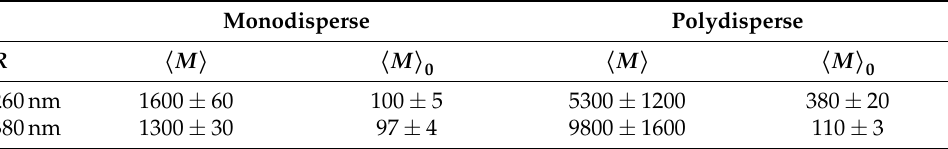
Table 1. Mean number (cid:104) M (cid:105) of Dextran segments in a Dextran aggregate ( (cid:104) M (cid:105) mixtures with χ ij = 0). Monodisperse